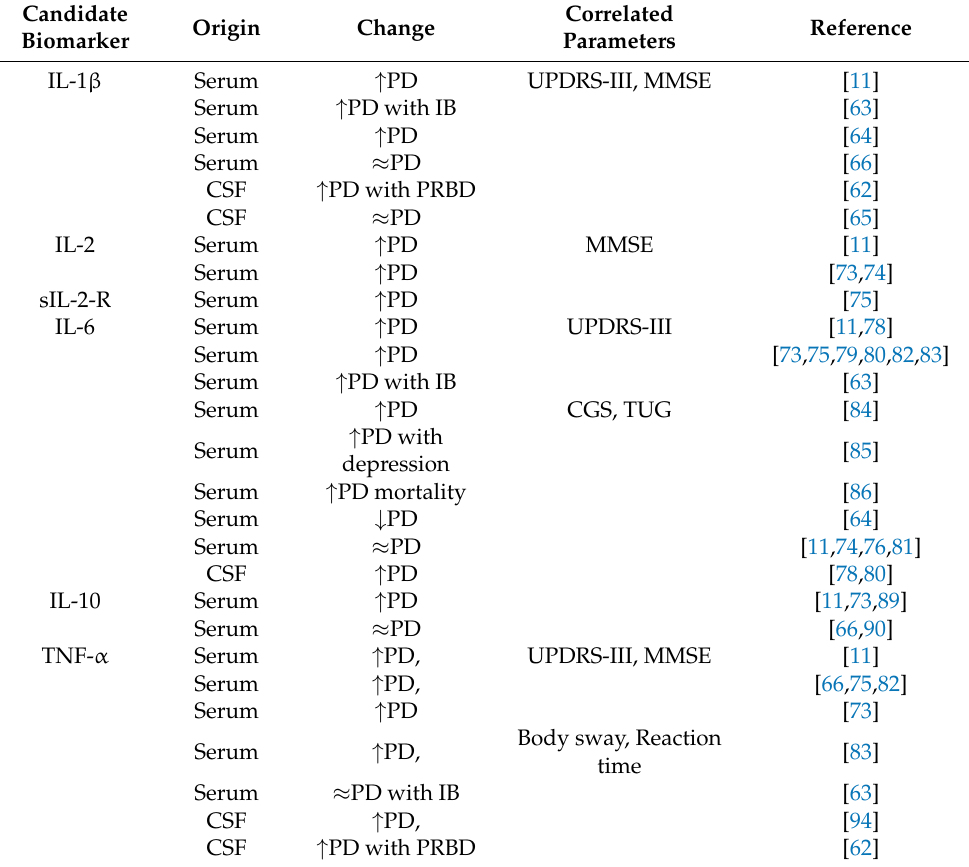
Table 1. Potential biomarkers involved in neuroinflammation in Parkinson’s